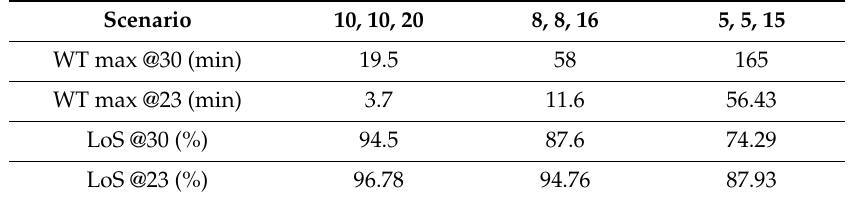
Table 1. Comparison of maximum waiting time (WT) and LoS with variable charging duration scenarios.